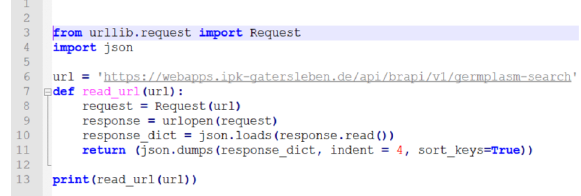
Figure 7: A Python Code Snippet to access RESTful endpoint Germplasm-search. The REST endpoints can also be accessible through Linux command line interface tools like